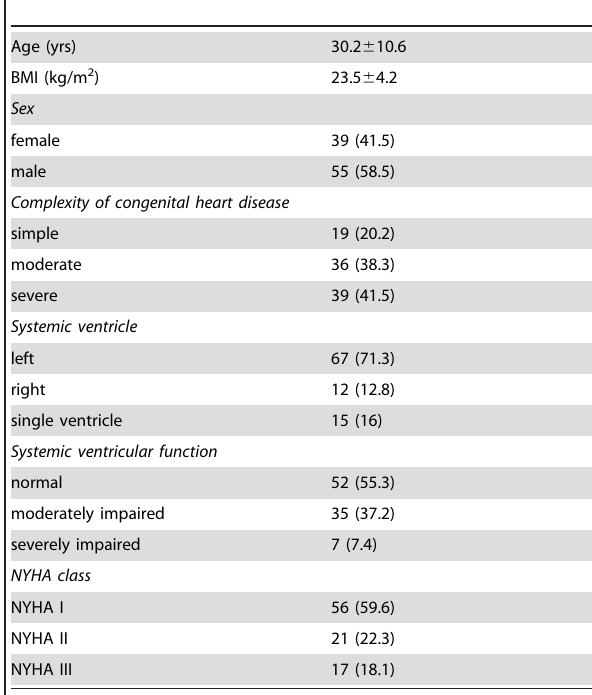
Table 1. Clinical characteristics of study